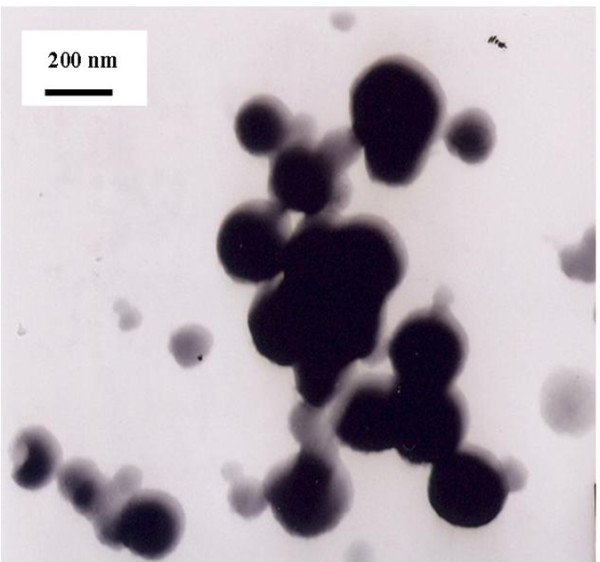
TEM micrograph showing the C60clusters in an aggregated state.